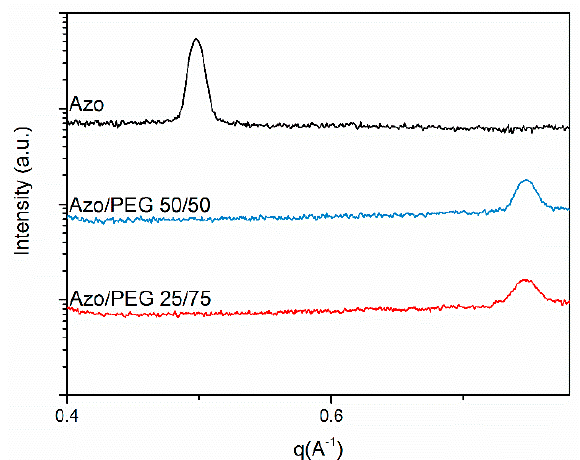
Figure 10. SAXS patterns of PEG and its complexes in combination with Azo at low q regions (measured at room temperature). The complex compositions are designated in wt %.